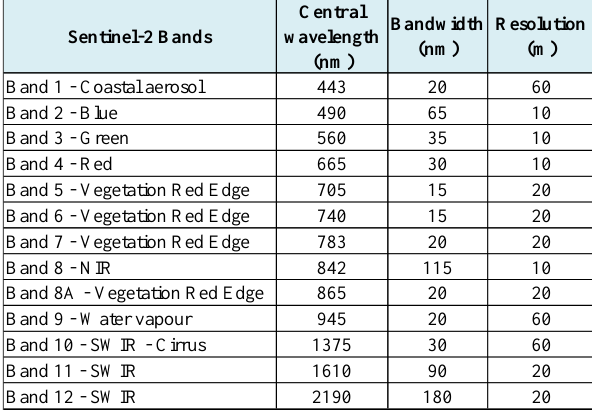
Table 3 . Features of Sentinel-2